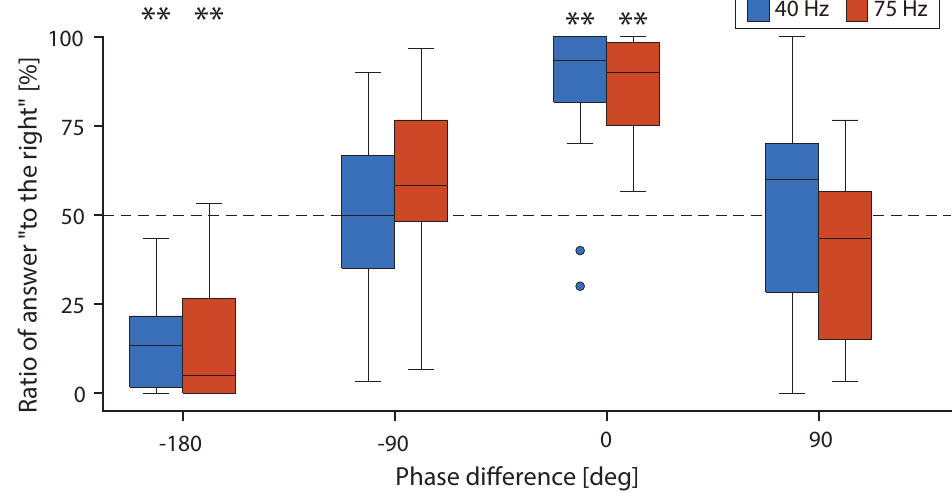
Figure 4. Plots of ratios of answers “to the right” at each